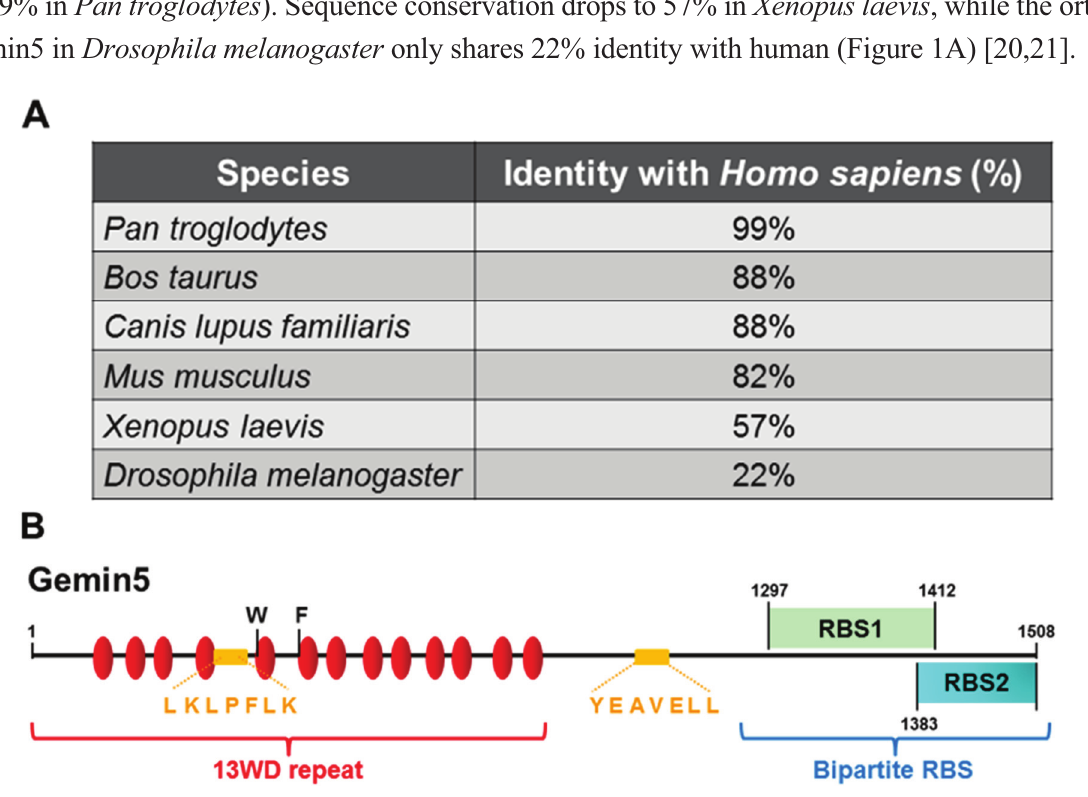
Figure 1. ( A ) Percentage of the identity of the human Gemin5 amino acid sequence with other species; ( B ) schematic representation of the functional domains of Gemin5. Red ovals depict WD repeat domains, green rectangles RBS1 and blue rectangle RBS2. The 4E-binding motifs are marked by orange letters and the position of W286 and F338 residues by black letters. Numbers indicate amino acid